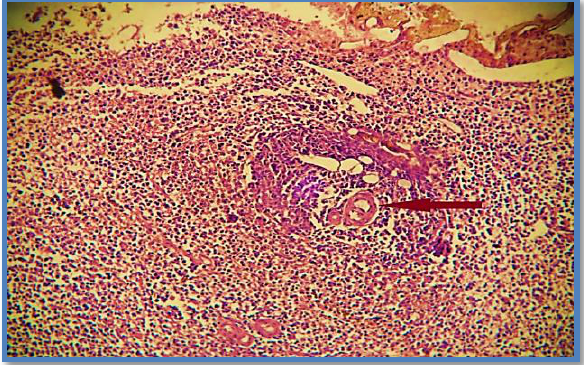
Figure, 15: Micrograph of goat group B aggregation of lymphocytes around central artery in the incision area (brown arrow) at 30th day postoperative (H and E 10